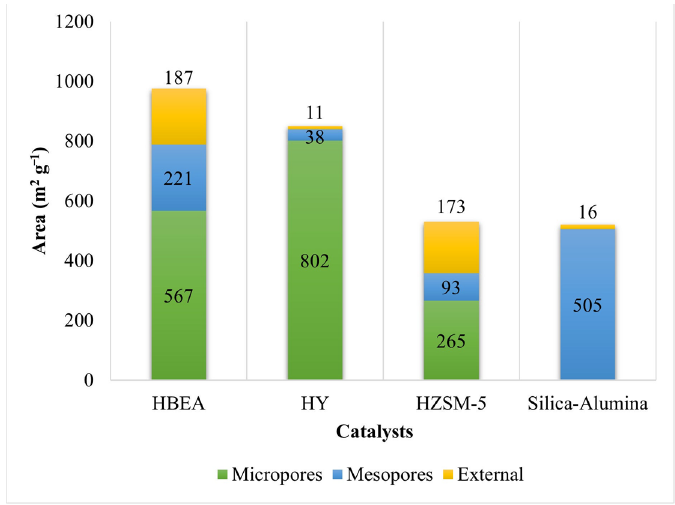
(2 σ ) was ± 5 m 2 g − 1 . b Total pore volume obtained by the amount of gas adsorbed at p/p 0 = 0.98. c Microporous volume obtained by t-plot method. d Crystallite domain size obtained by XRD using Scherrer’s equation ( ± 5 nm).